Question: Sum up the contents of this chart in one sentence.
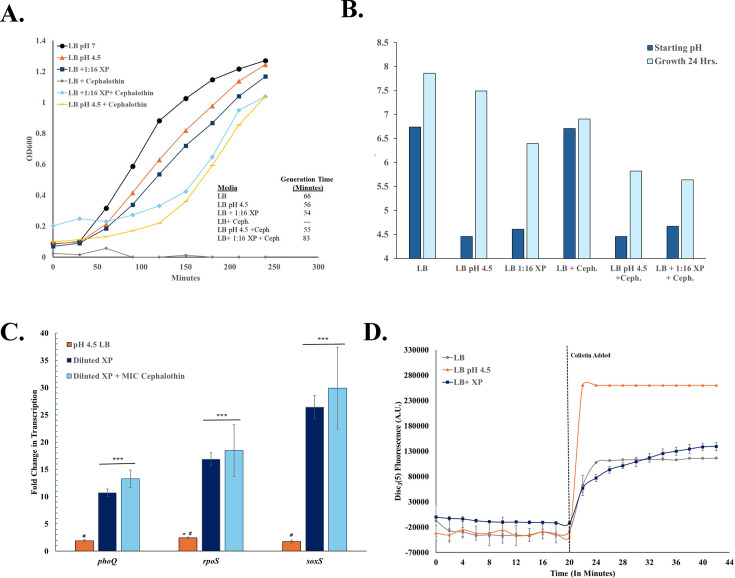
Answer: Acidic pH and XP induce a transcriptionally regulated adaptive resistance phenotype with a distinct XP-dependent membrane polarization profile. K. pneumoniae 4816 was grown in neutral LB, pH 4.5 LB, or 1:16 XP with or without 16 μg/mL cephalothin. ( A ) OD 600 of cultures was determined 30 min over the course of 4 h. Generation time was calculated from the specific growth rate of the exponential portion of each curve. ( B ) pH of cultures at the start and end of 24 h incubation in each growth medium. ( C ) Transcription of three stress response regulators was determined by qPCR. Relative transcriptional levels were determined using the ΔΔCt method, comparing against the housekeeping gene gapA and the untreated growth strain in neutral LB. N = 3 independent assays. Bars represent standard error. Statistical comparisons were conducted using ΔCt values to allow for comparison relative to the expression of each gene in untreated culture. * P < 0.05, *** P < 0.0001 relative to neutral LB. # P < 0.05 as compared to cultures containing dilute XP. ( D ) K. pneumoniae equilibrated with the voltage-sensitive dye DiSC 3 (5) for 20 min and exposed to 10× MIC colistin (dashed vertical line). Depolarization is measured via an increase in fluorescence measured every 2 min. Flat readings after colistin addition represent maximum depolarization. N = 6 per treatment. Error bars represent standard deviation.